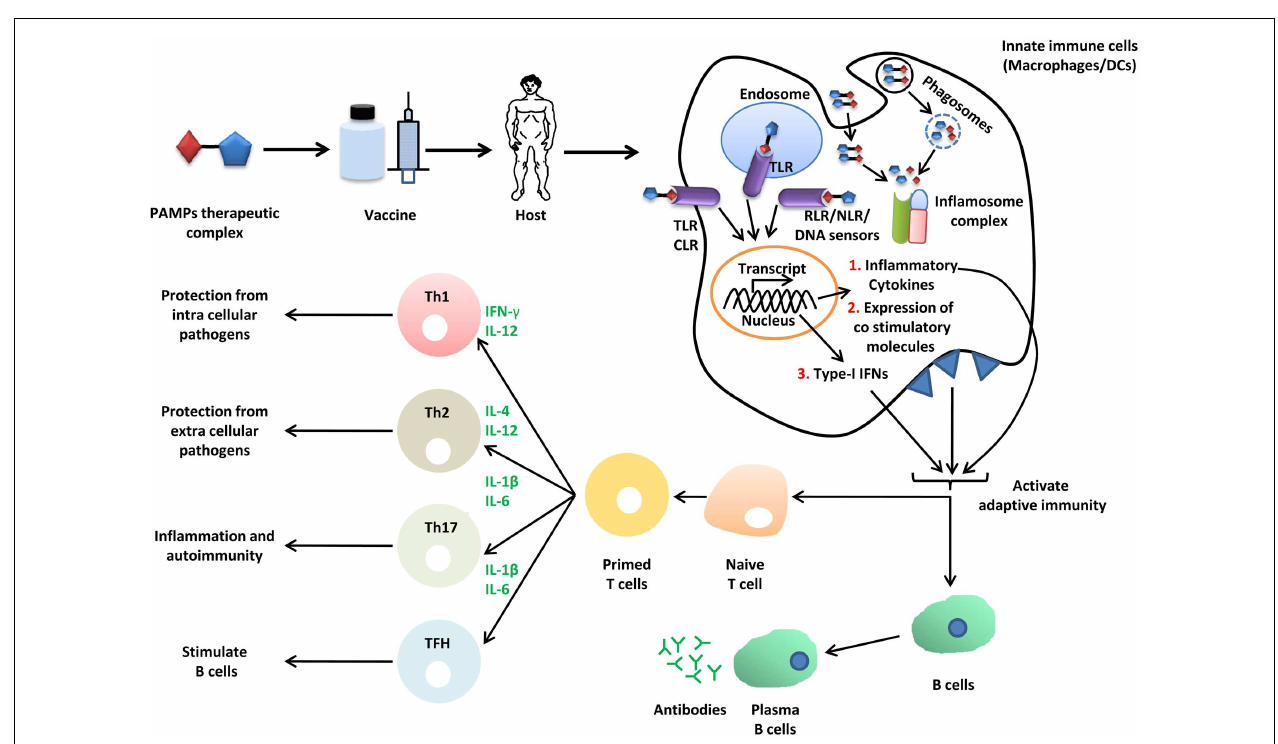
DNA sensors), induce secretion of inflammatory cytokines and type-I IFNs. These cytokines further activate adaptive immune components through B and T lymphocytes. Adaptive immune memory cells protects host from